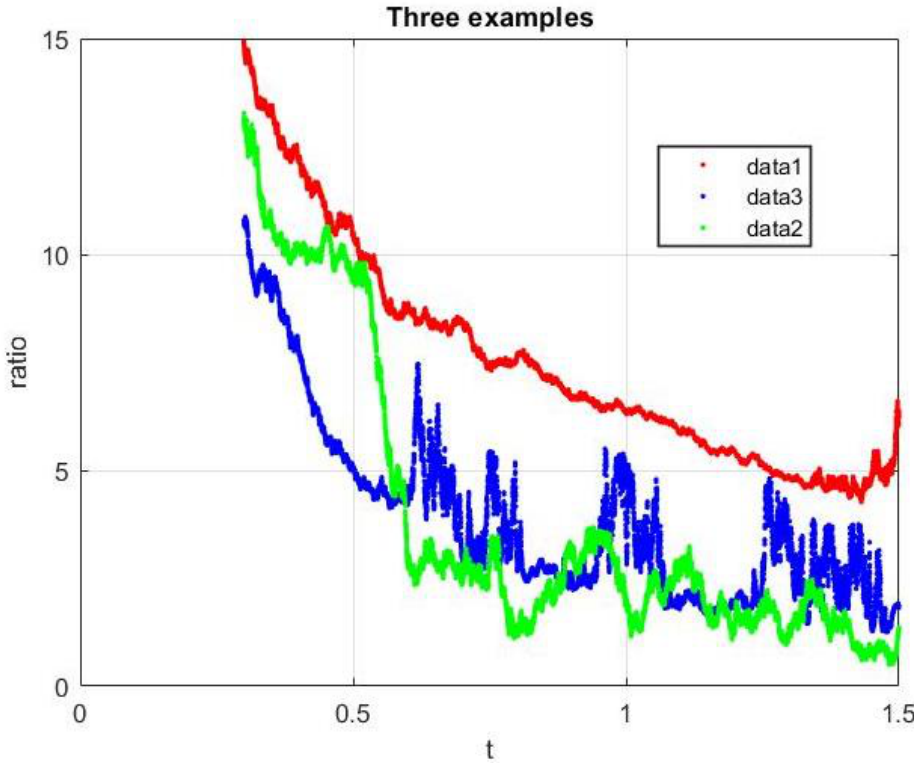
Figure 6. Evolution of the R ( t ) with